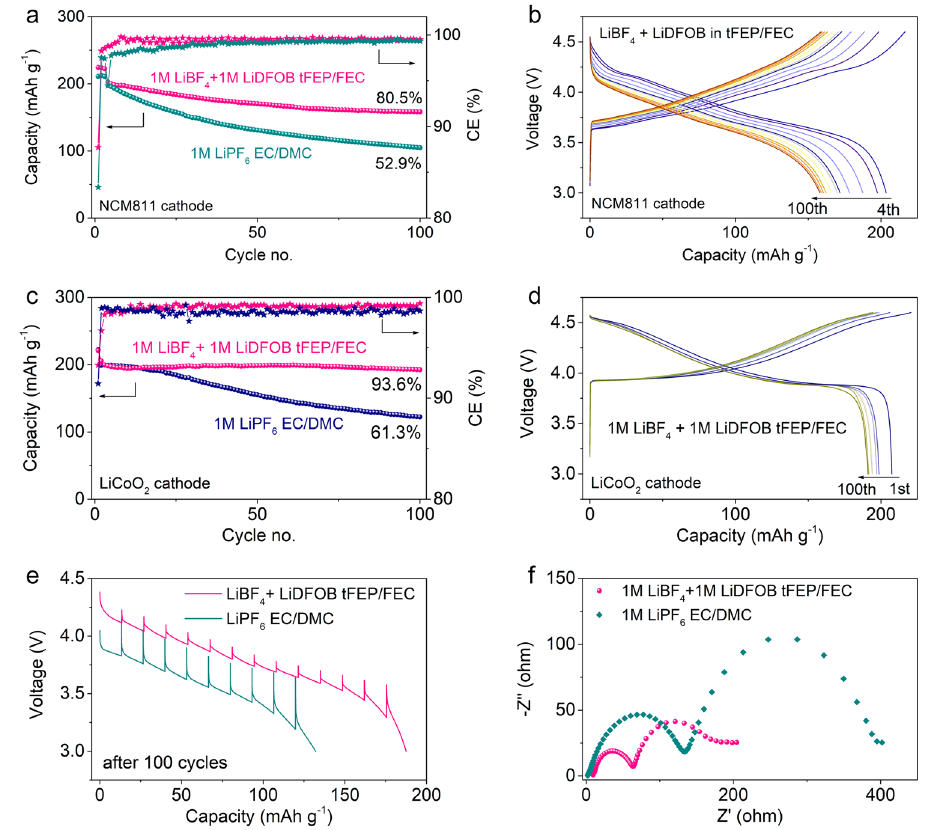
Fig. 4 | Electrochemical performance of 4.6V NCM811 and LiCoO 2 cathode. CyclingperformanceandCEof a NCM811cathodeand c LiCoO 2 at0.5Crate(0.2C for the fi rst three cycles, 1C=200mAhg − 1 ). Corresponding voltage pro fi les of b NCM811 and d LiCoO 2 cathode in 1M LiBF 4 +1M LiDFOB tFEP/FEC electrolyte. e Discharge voltage pro fi les of galvanostatic intermittent titration technique